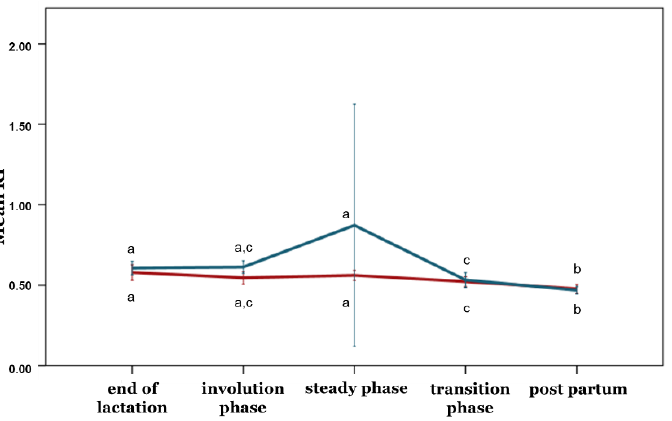
Figure 5. Resistive index changes among the periods and between the ewe groups ( p ≤ 0.05). The different letter indicators (a, b, c) represent statistically significant differences between the periods. The green line represents the ewe group with healthy udders, while the red represents the ewe group with subclinical mastitis.